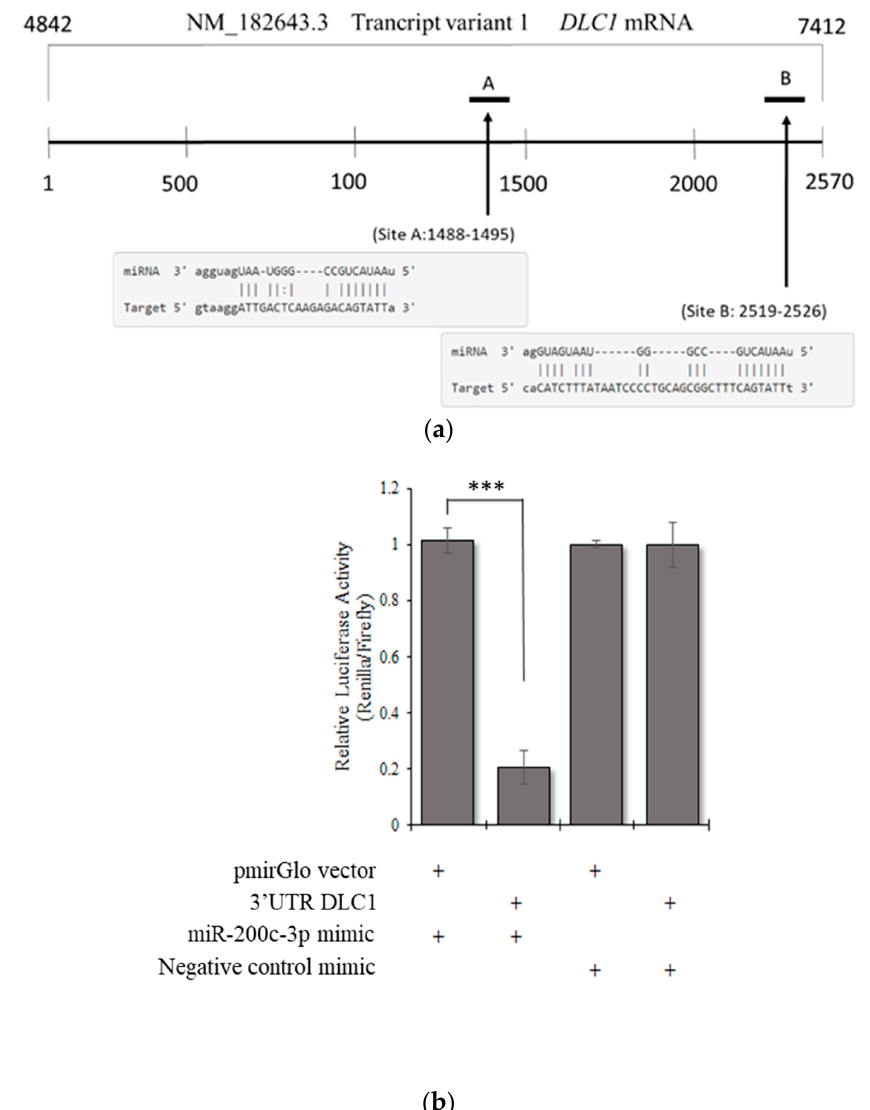
Figure 2. ( a ) Two putative binding sites of 3’UTR DLC1 from in silico analysis. ( b ) There was a significant reduction in the luciferase activity when 3’UTR DLC1 construct was co-transfected with miR-200c-3p mimic. Significant values are indicated as follows: *** p < 0.001.